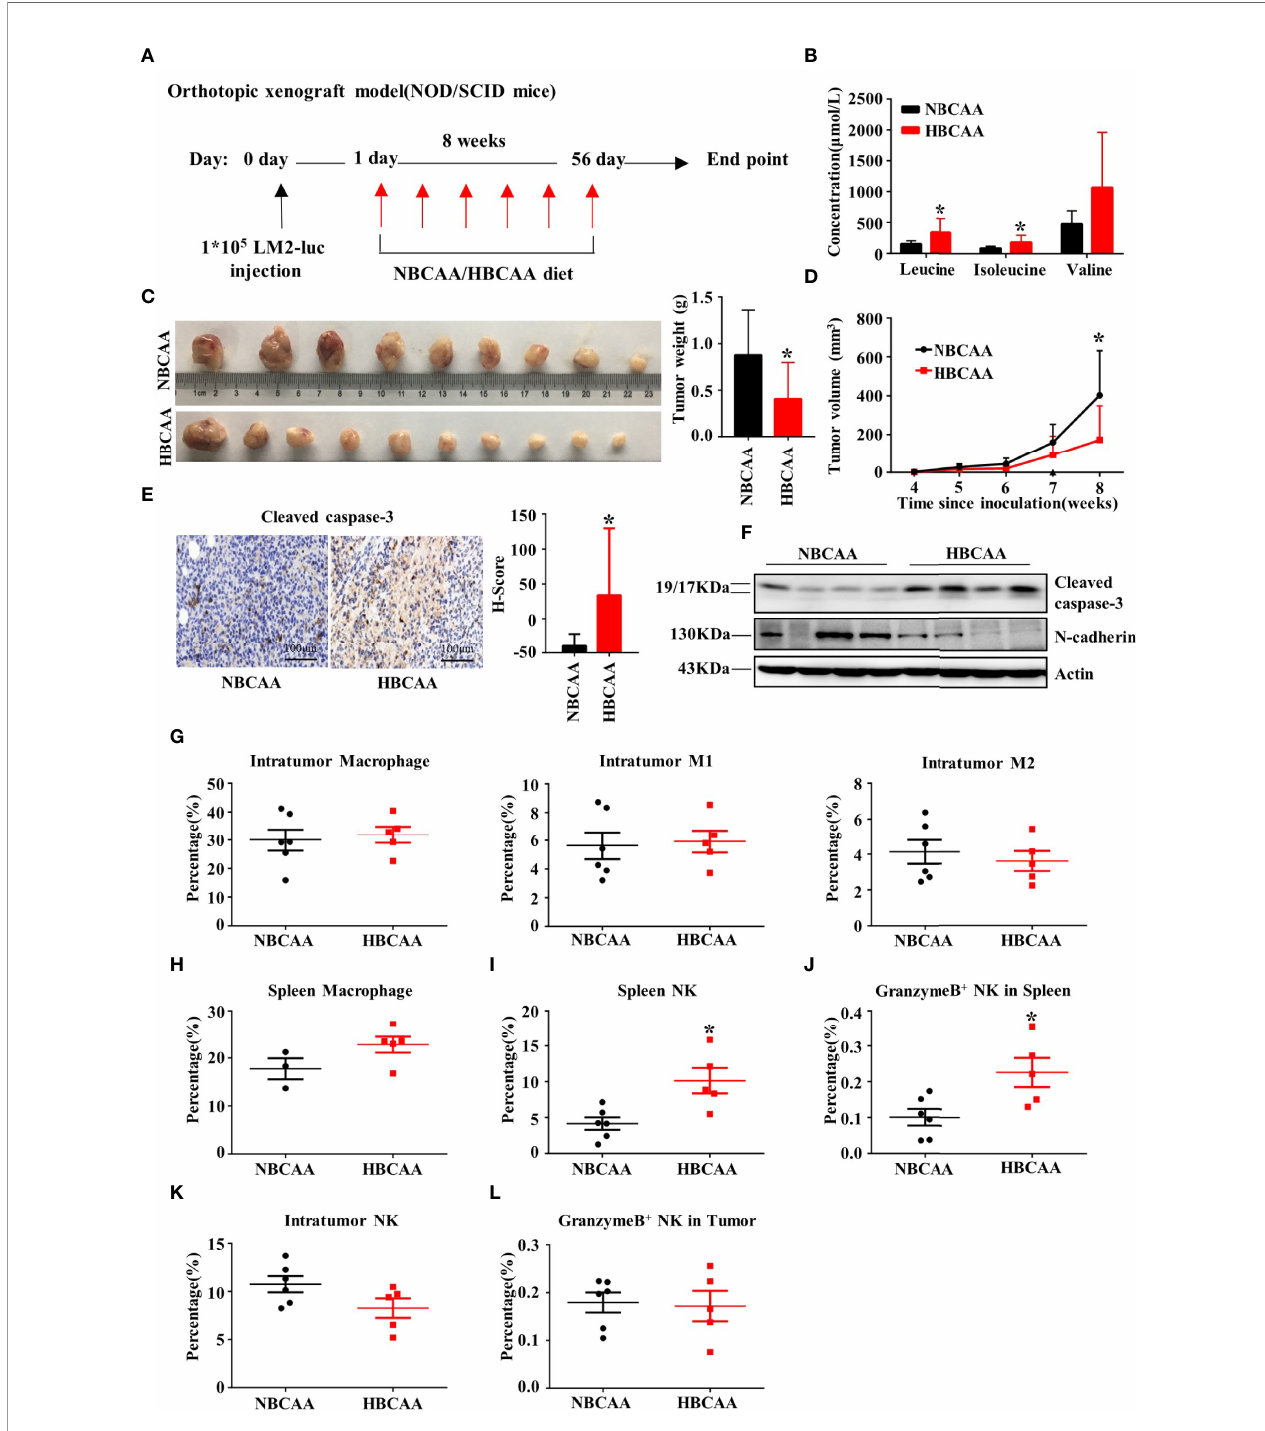
FIGURE 4 | Increasing dietary BCAA intake suppresses tumor growth in the orthotopic xenograft model. (A) Orthotopic xenograft model (normal BCAA Diet, n =9; high BCAA Diet, n =10). (B) The serum BCAA concentration of tumor-bearing mice. (C) Tumors were harvested and tumor weight was measured at the end of the experiment. (D) Tumor volume was measured per week and calculated using the following formula: tumor volume (cubic millimeters (mm 3 )) = 0.5× (length × width 2 ). (E) Apoptosis marker Cleaved caspase-3 were analyzed by immunohistochemistry ( n =9 in each group). (F) Western blot to detect Cleaved caspase-3 and N- cadherin expression of tumor tissues. (G) The percentage of macrophage, type-I macrophage and type-II macrophage in tumor was analyzed by fl ow cytometry. (H) The percentage of macrophage in spleen. (I) The percentage of NK cell in spleen. (J) The percentage of NK cell expressing Granzyme B in spleen. (K) The percentage of NK cell in tumor. (L) The percentage of granzyme B + NK cells in tumor. Mean ± SD, *p < 0.05, Student ’ s